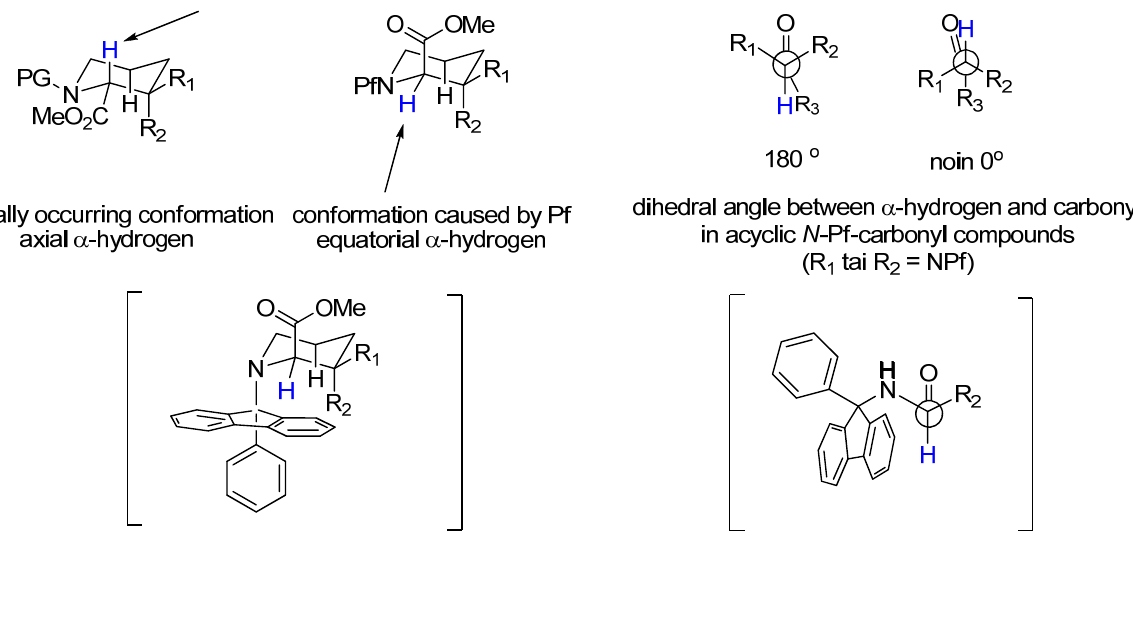
Figure 1. Conformational analysis of cyclic and acyclic